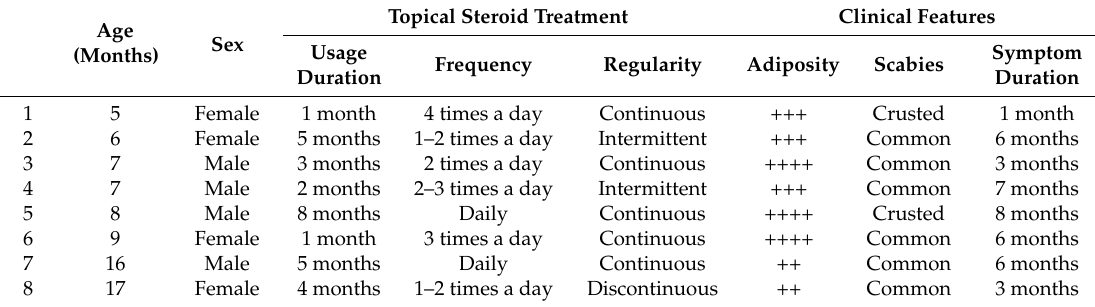
Table A1. Cases of scabies and iatrogenic Cushing